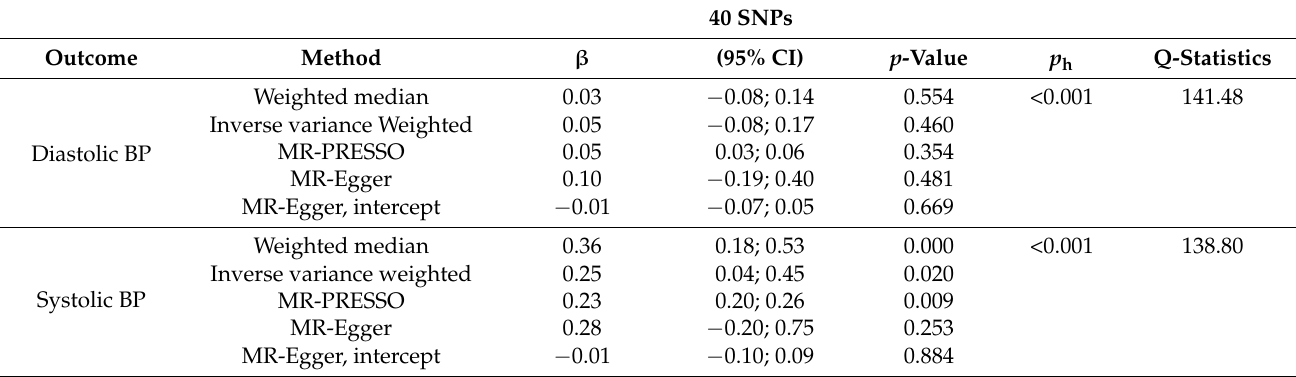
Table 2. Causal estimates of age at natural menopause with blood pressure traits (systolic and diastolic blood pressure) using methods implemented in the MR-Base with data from the GWAS of ANM and UK